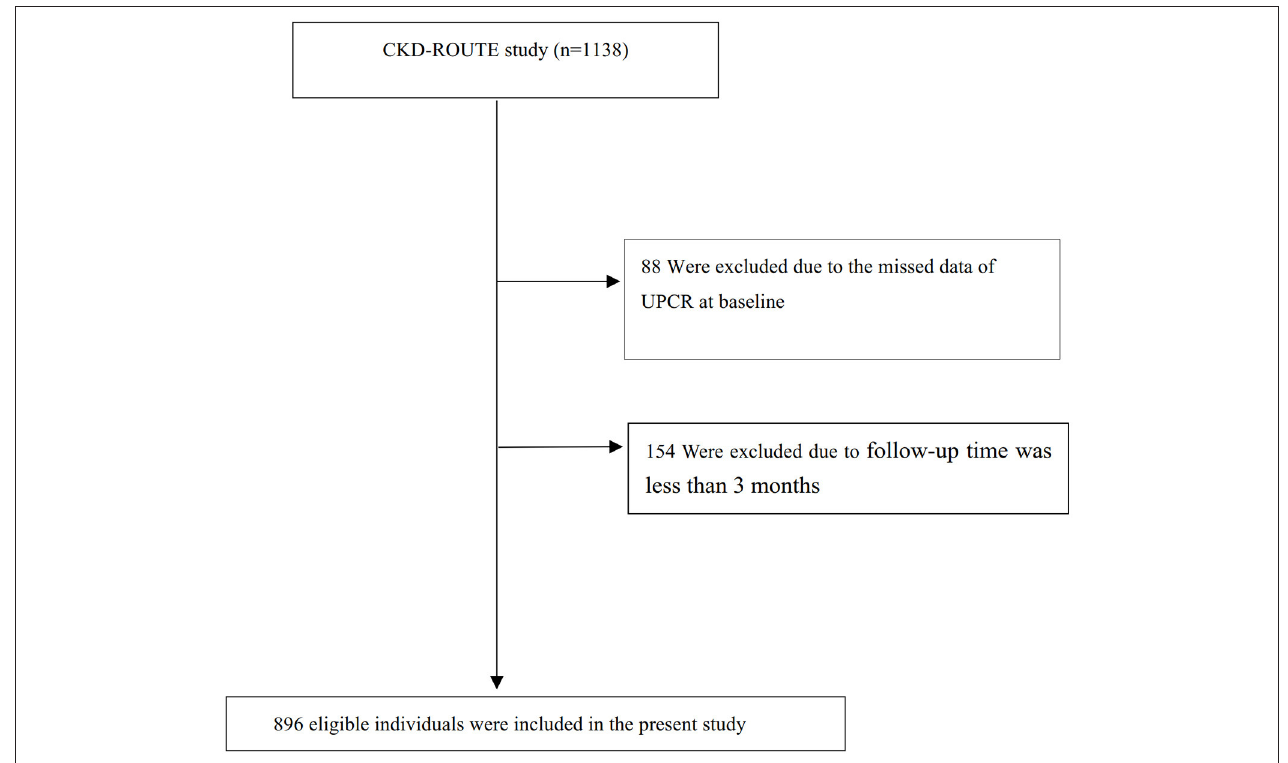
FIGURE 1 | Flowchart of study